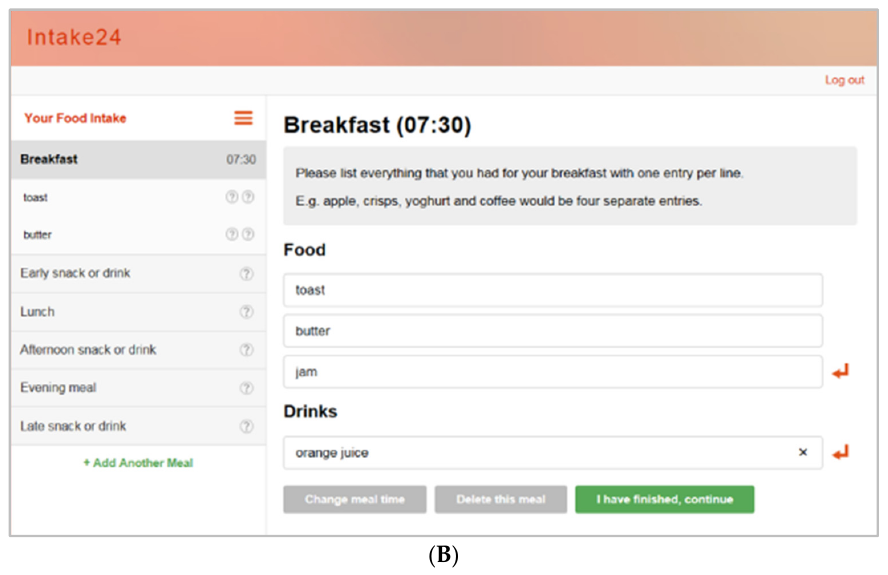
Figure 1. Screen shots of INTAKE24; ( A ) User instructions for INTAKE24; ( B ) Food and drink entry interface.